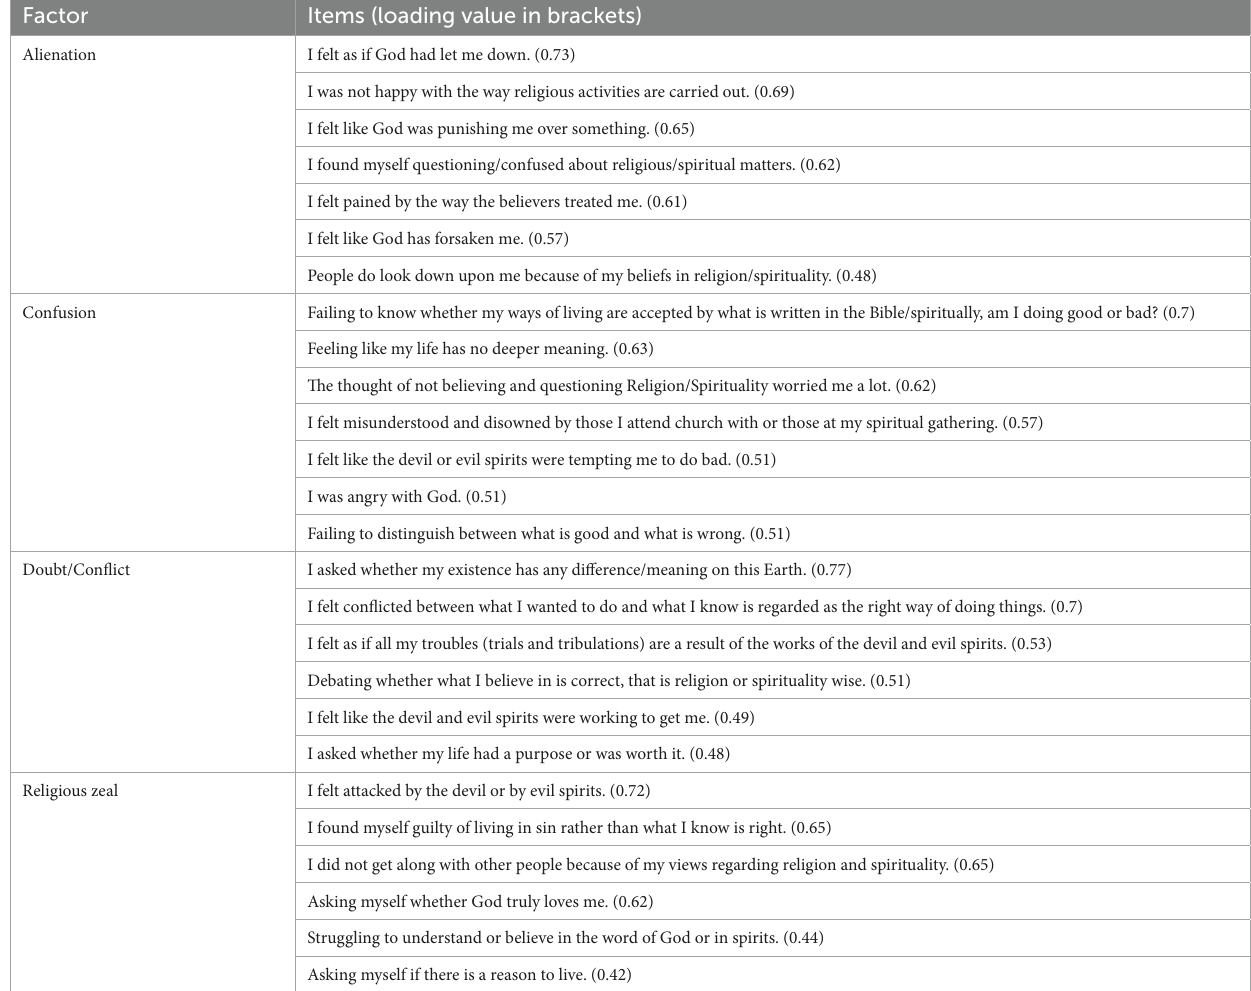
TABLE 2 Factors resulting from the principal component factor analysis. Factor Items (loading value in